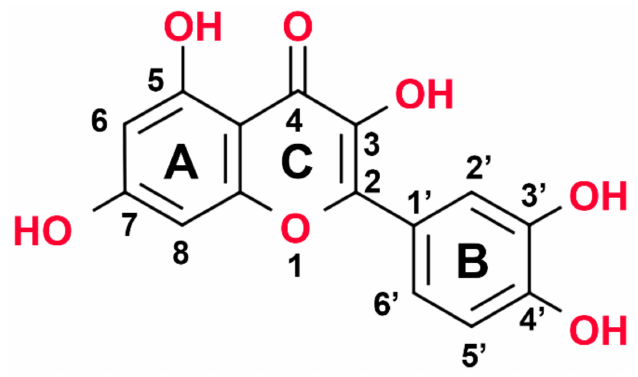
Figure 1. The structural formula of